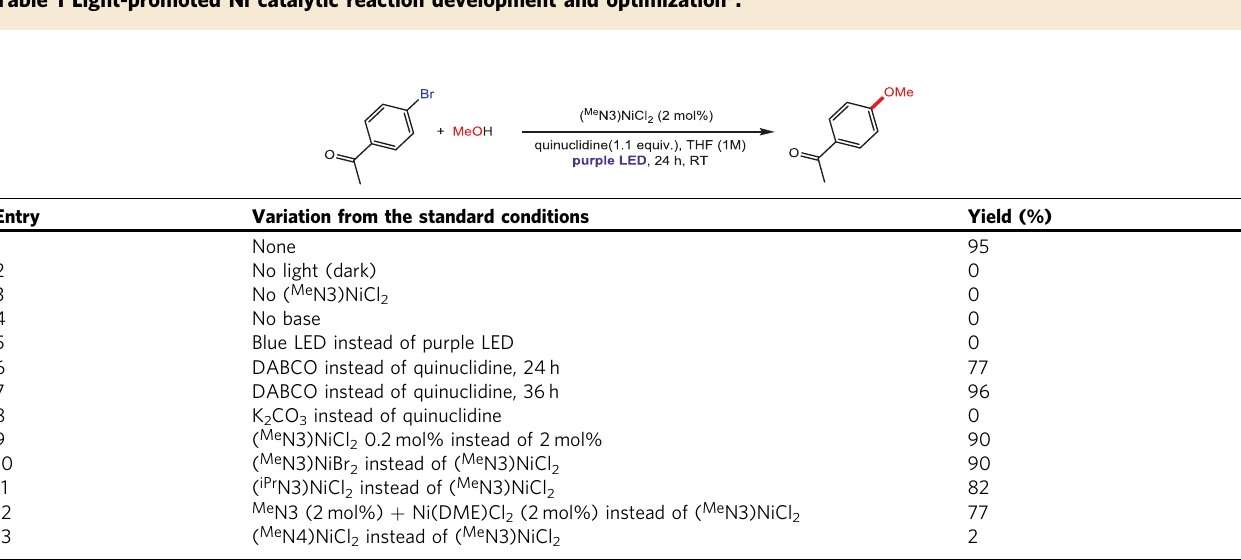
Table 1 Light-promoted Ni catalytic reaction development and optimization a